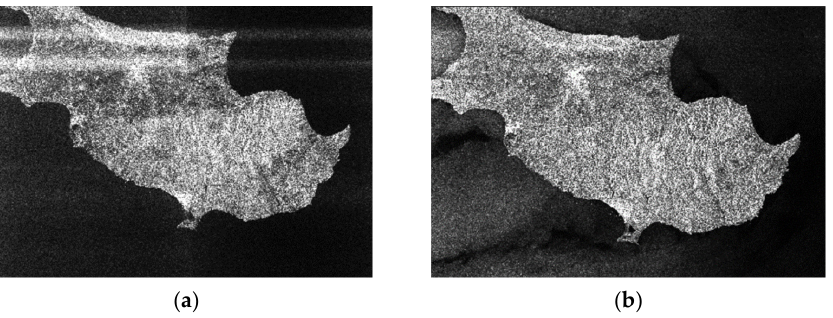
Figure 3. Comparison of intensities of Sentinel-1 product with dual polarization, ( a ) Vertical-Horizontal (VH) and ( b ) Vertical-Vertical (VV).